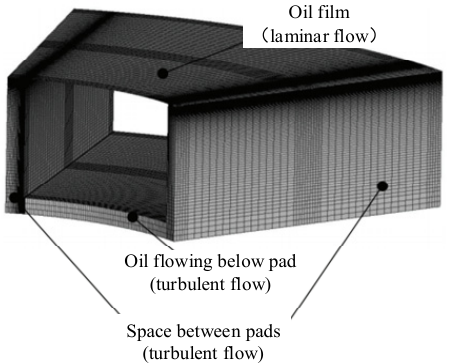
Figure 11. Laminar and turbulent flow zone of bearing pad model [108].